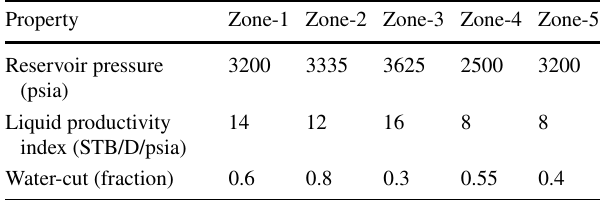
Table 1 Zonal properties of the five-zone I-well